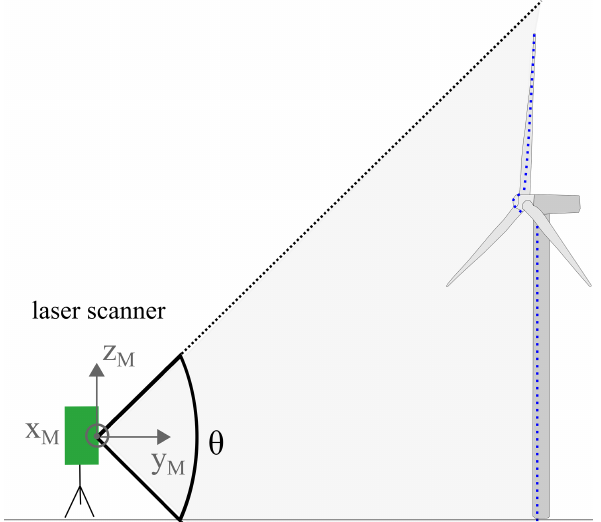
Figure 1. Sketch of the measurement arrangement: the laser scan- ner (in green) with the scan angle θ is aligned vertically to the wind turbine. The points that are reflected by the wind turbine (blue dots) are measured in the y M , z M coordinate system.